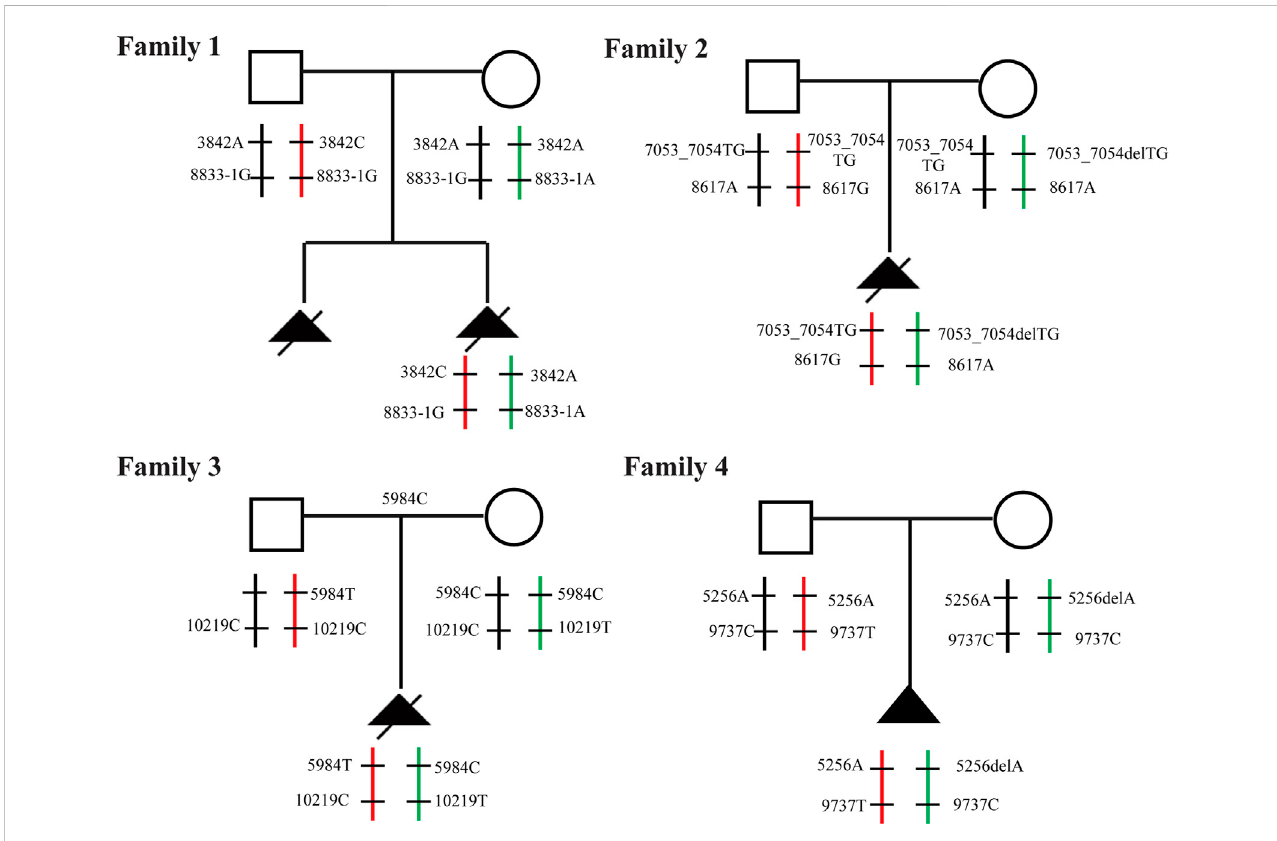
FIGURE 9 Familial pedigree Pedigree with autosomal recessive SRTD3 displaying cosegregation of the compound heterozygous changes within the DYNC2H1 gene in four